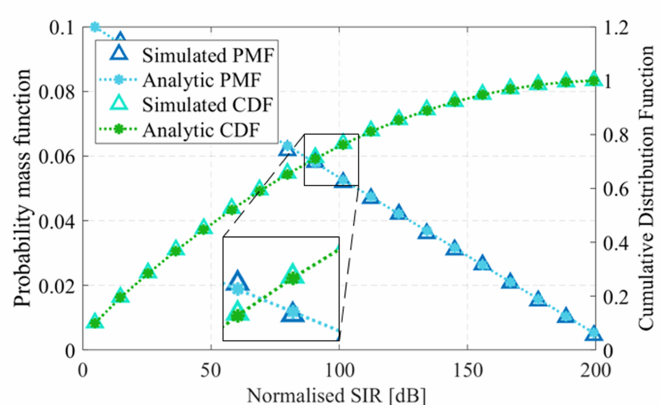
Figure 9. Probability mass function (PMF) and cumulative distribution function (CDF) of the normalized signal-to-interference ratio (SIR) with a frequency guard of g = 0.5 MHz and N = 100